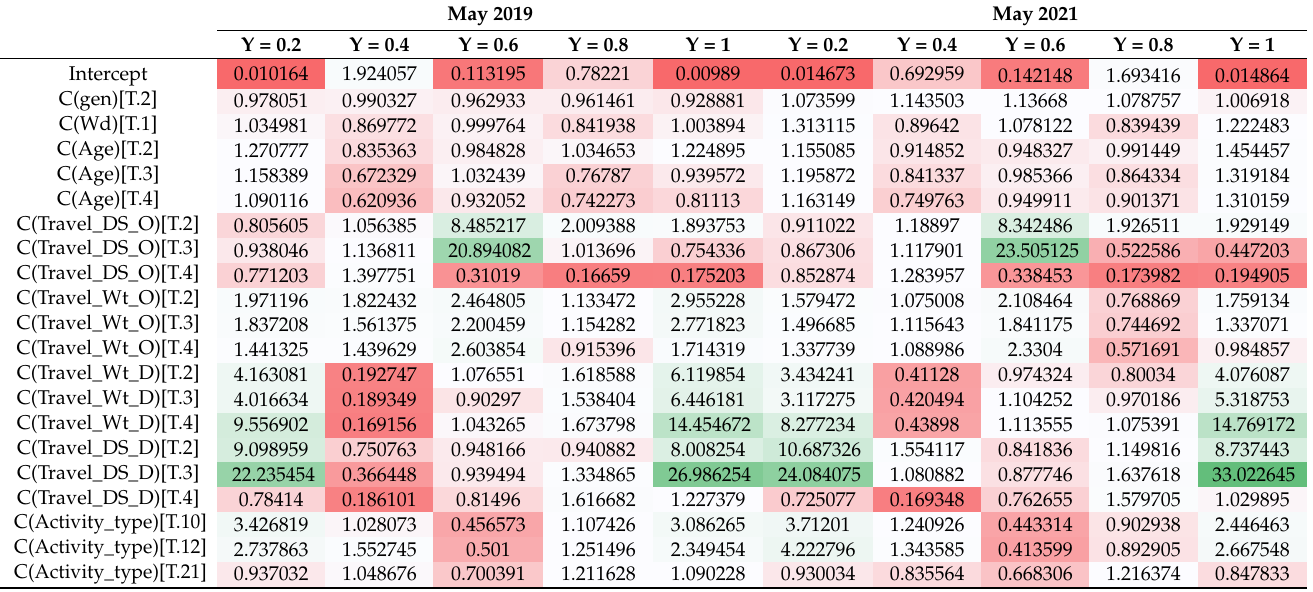
Table 12. Odds Ratios of multinomial logit